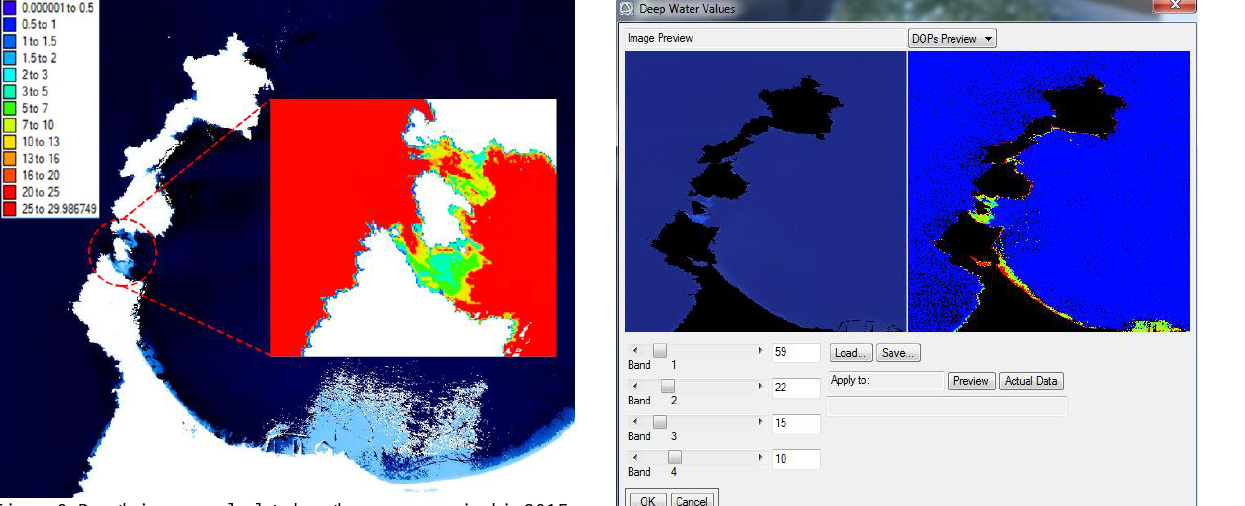
Figure 9. Depth images calculated on the scene acquired in 2015.